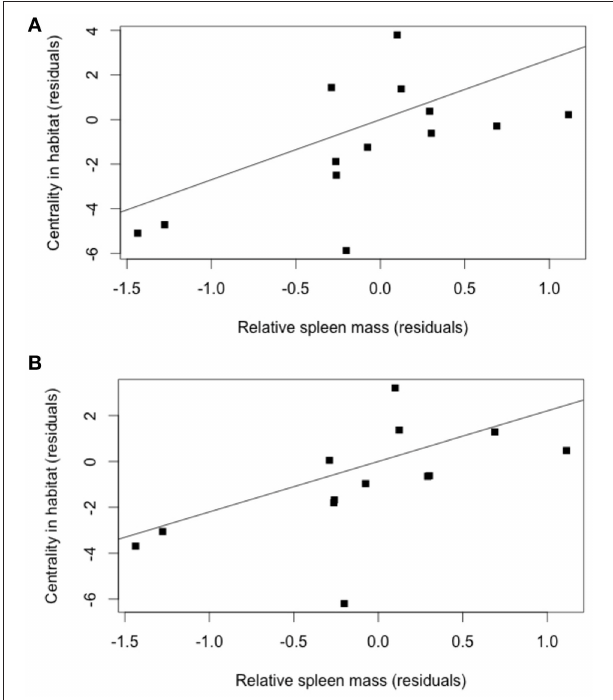
FIGURE 3 | (A) Partial regression between the residuals of contrasts in spleen size in females and the residuals in centrality in habitat (controlling for the contrasts in host abundance and parasite species richness, using the model of Table 3 ); ( R 2 = 0.38 , P = 0 .02). (B) Partial regression between the residuals of contrasts in spleen size in males and the residuals in centrality in habitat (controlling for the contrasts in host abundance and parasite species richness, using the model of Table 3 ); ( R 2 = 0.34 , P = 0 .03).